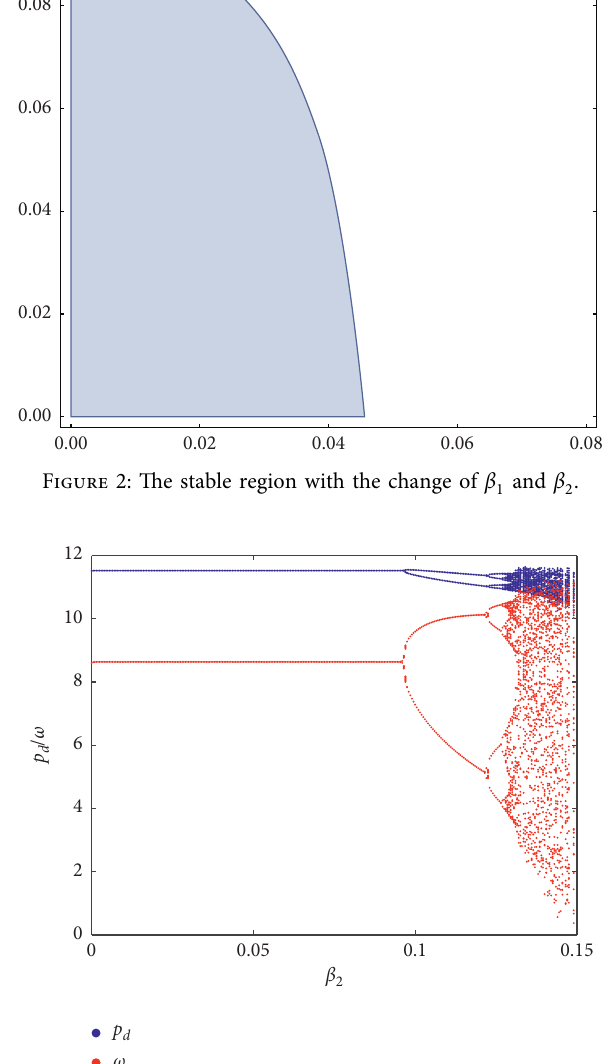
� 0 . d and ω when β 1